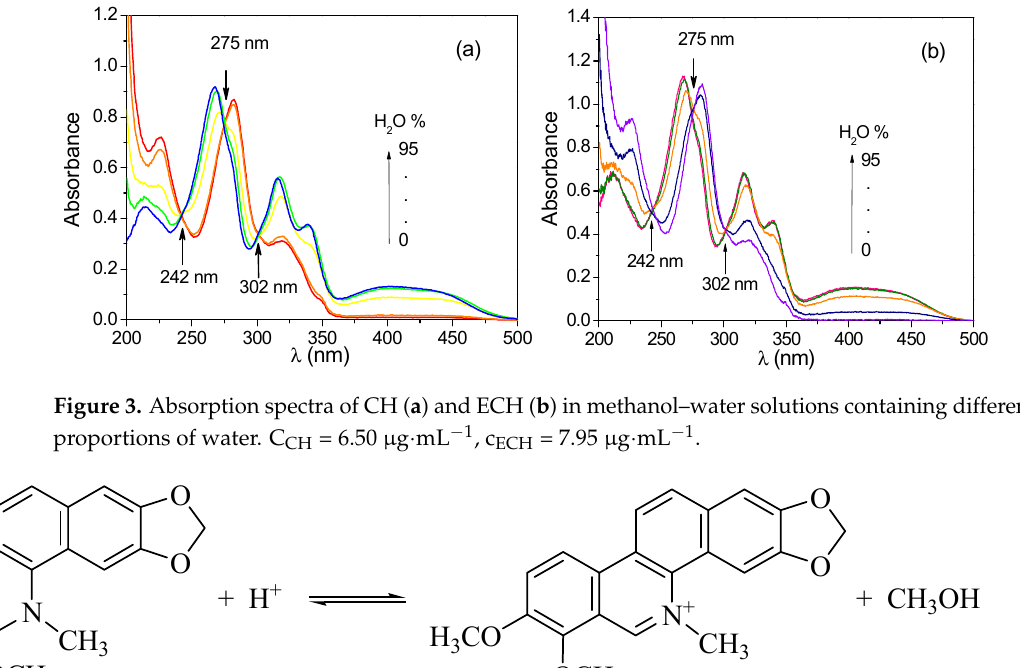
Scheme 4. Conversion of MCH in methanol to CH + when diluted with water .